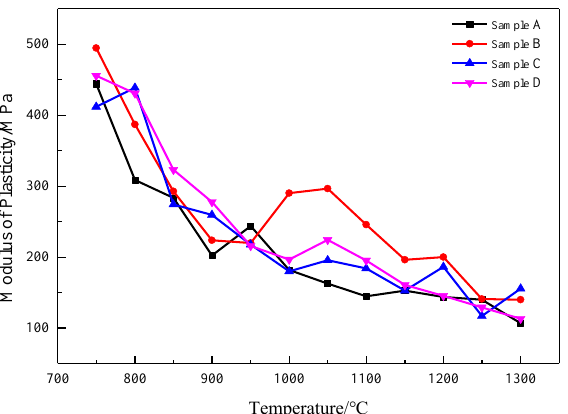
Figure 8. The relationship between the plastic modulus of high-rise structural steel with different Nb contents and temperatures.